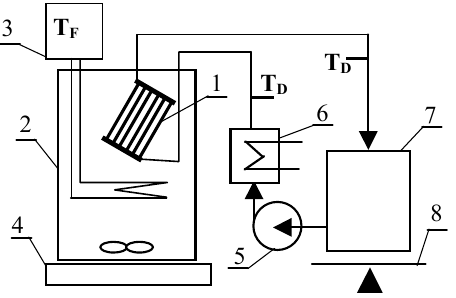
Figure 1. Scheme of experimental set-up. 1—MD module; 2—crystallizer; 3—Nüga temperature